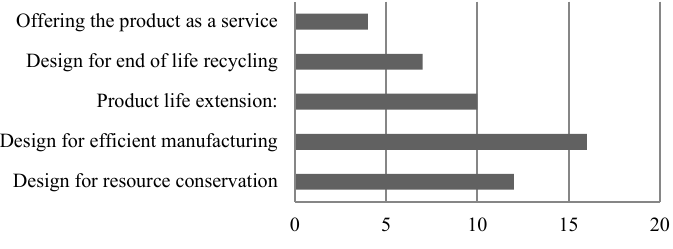
Fig. 2. Use of a circular design approach in the company's product development.